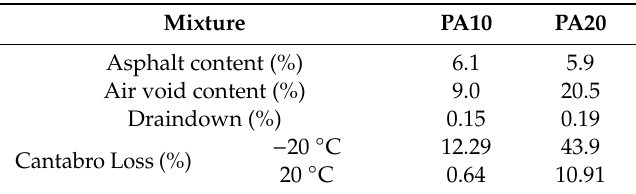
Table 2. Properties of PA10 and PA20.